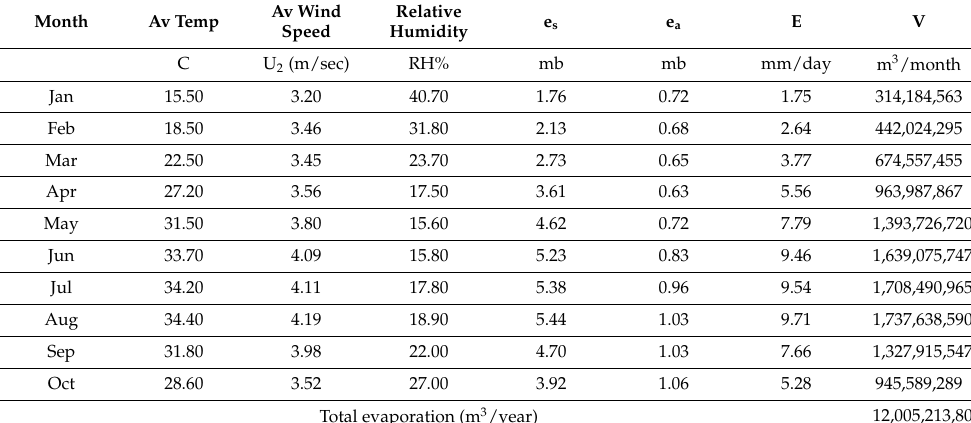
Table 5. Monthly water saving using a floating photovoltaic system (FPVS) at Lake Nasser.